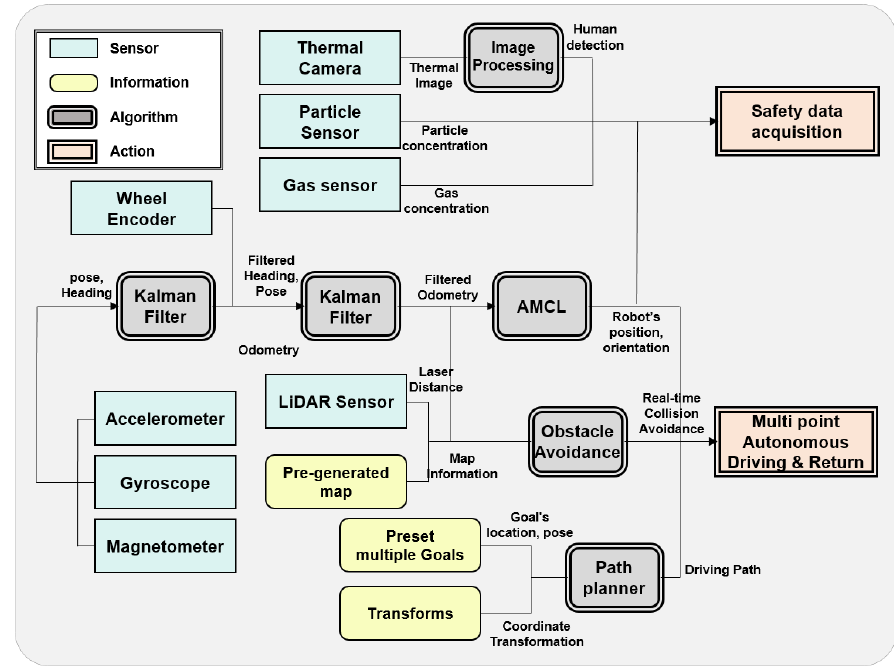
Figure 2. Autonomous driving robot and sensors used in this study.